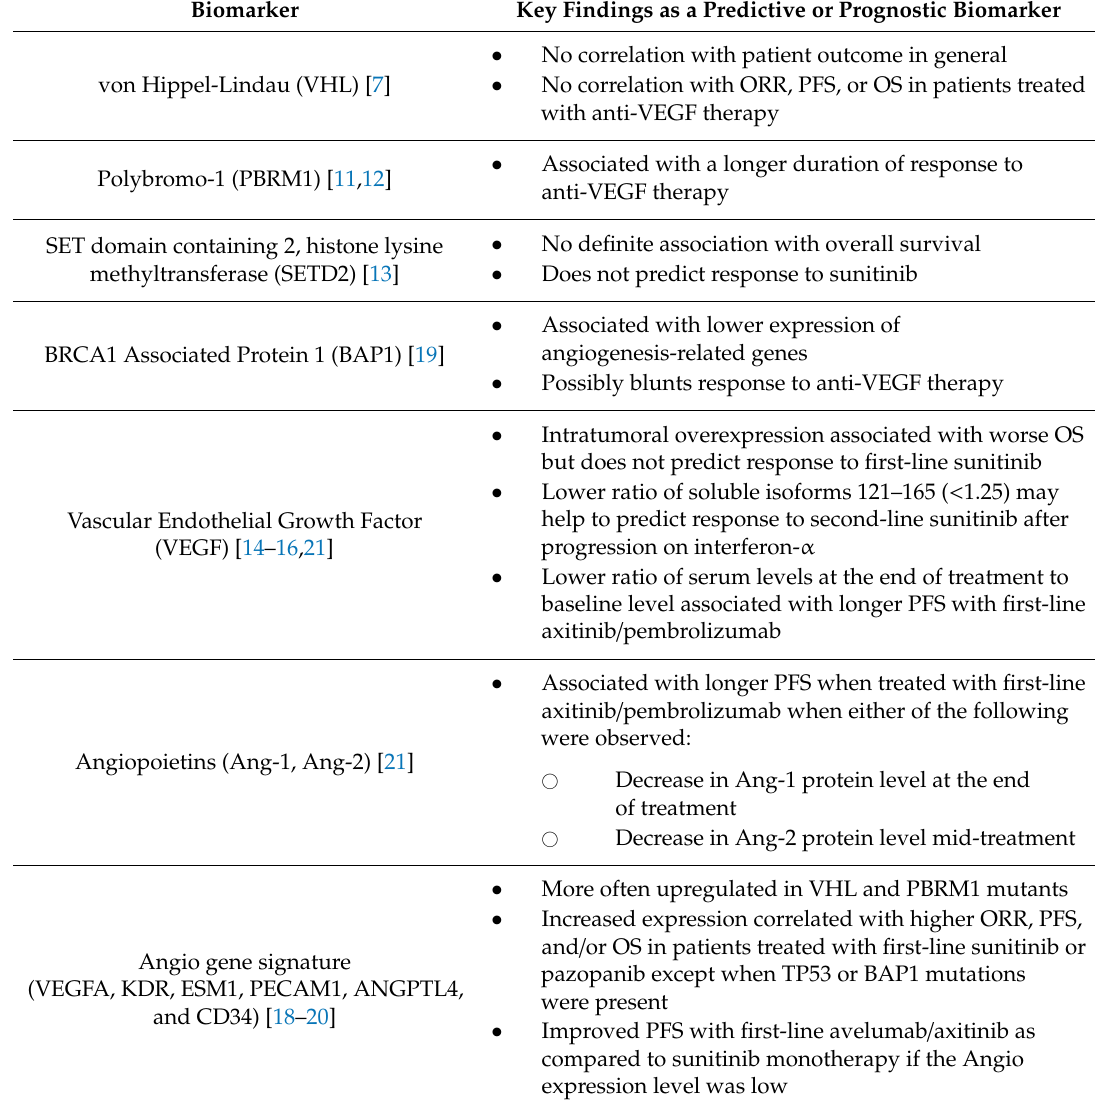
Table 1. Summary of biomarkers for angiogenesis